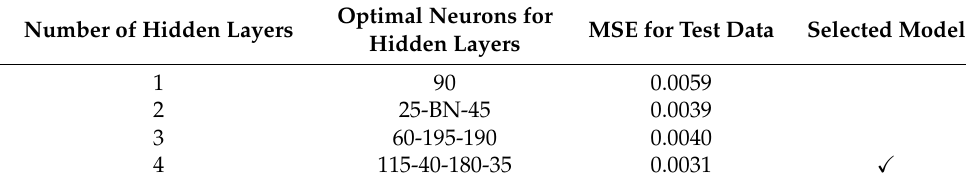
Table 3. Optimal neurons for hidden